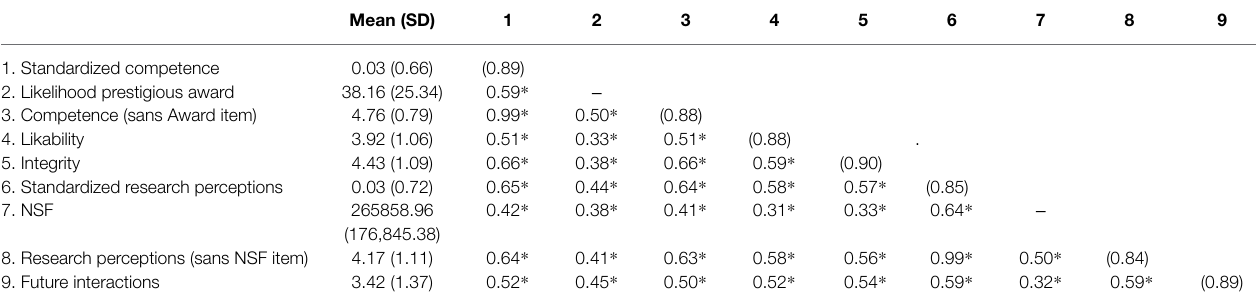
TABLE 3 | Descriptives and correlations among all outcomes in Study 2.